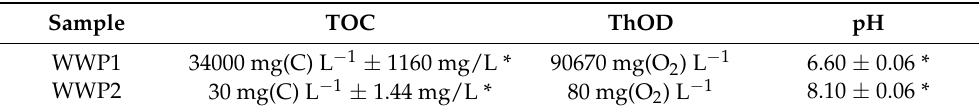
Table 1. The TOC, ThOD, and pH values of the WWP1 and WWP2 samples. Sample TOC ThOD